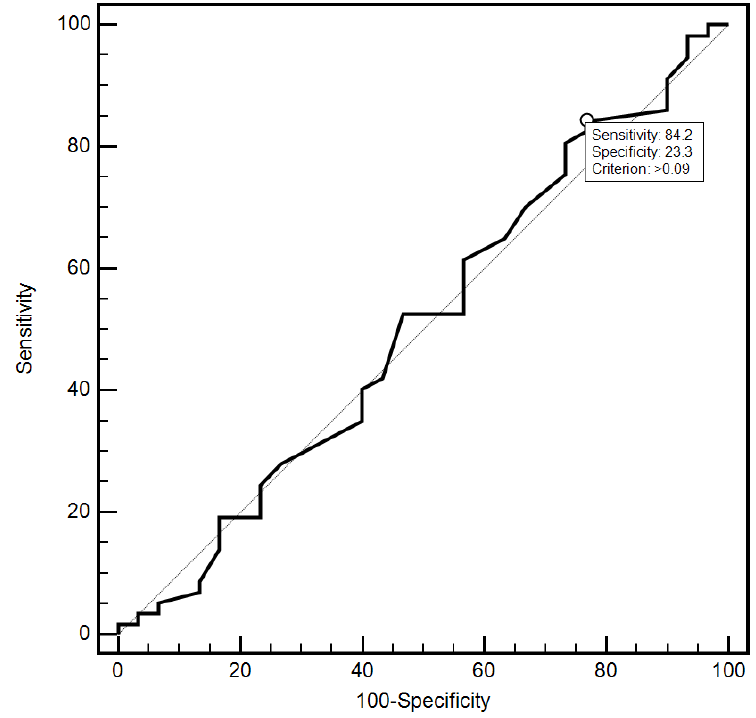
Figure 8. Evaluation of the diagnostic usefulness of the deformity parameter in the early detection of preterm labor using the ROC